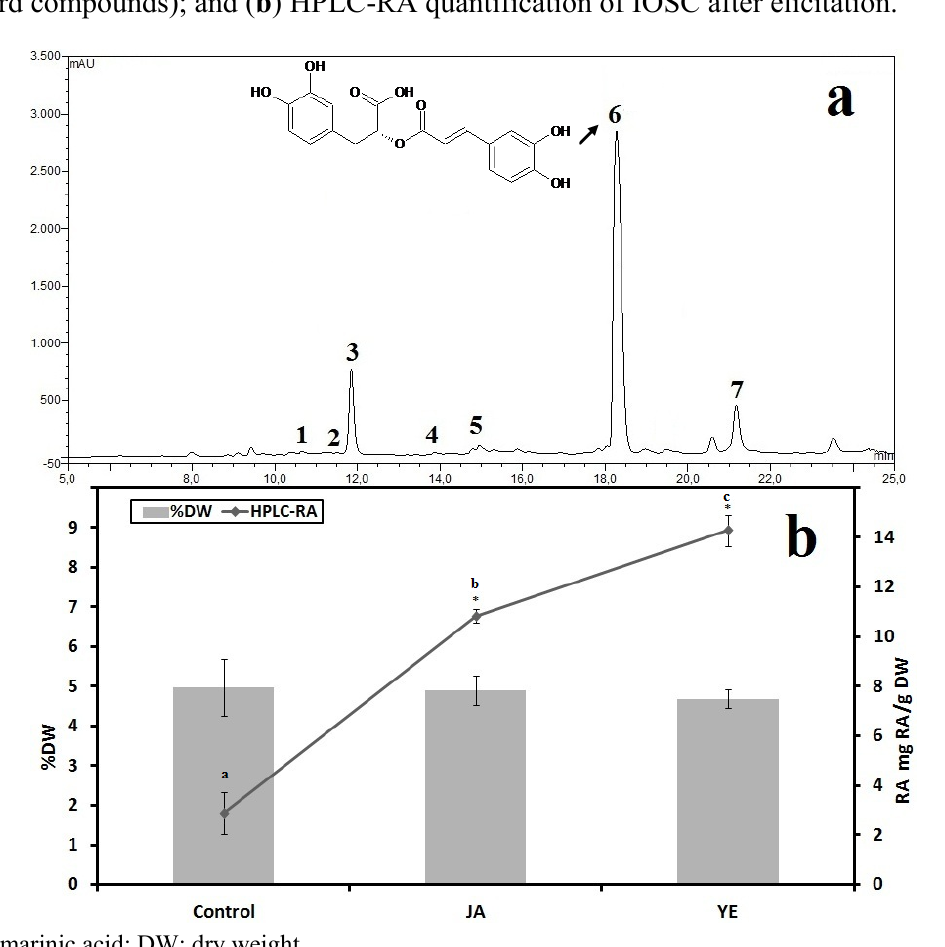
Figure 4. ( a ) Typical HPLC chromatogram of IOSC extract subjected to